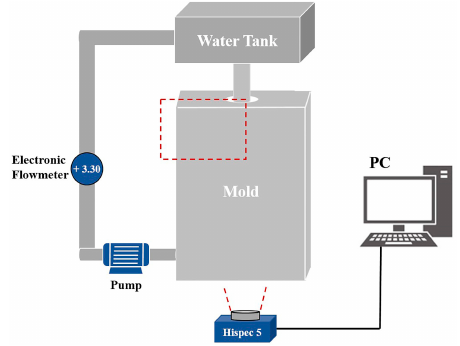
Figure 2. Schematic drawing of the experimental apparatus.